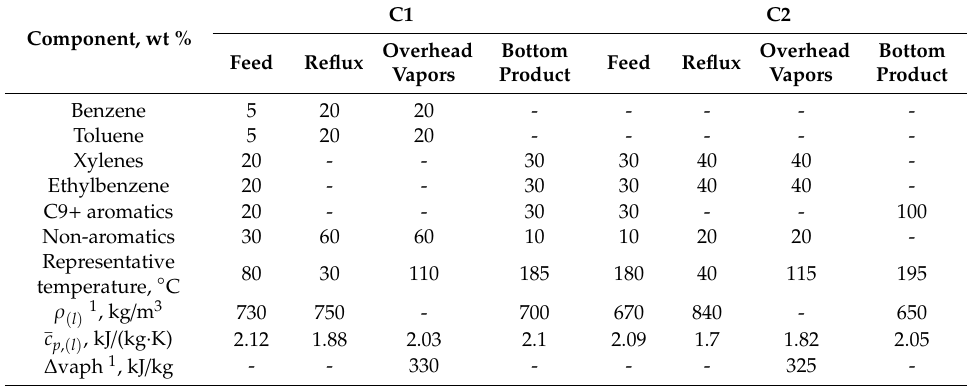
Table 3. Representative composition and physical properties approximation for C1,2 process streams. Nonaromatics are represented by n-pentane; C9 + aromatics are represented by